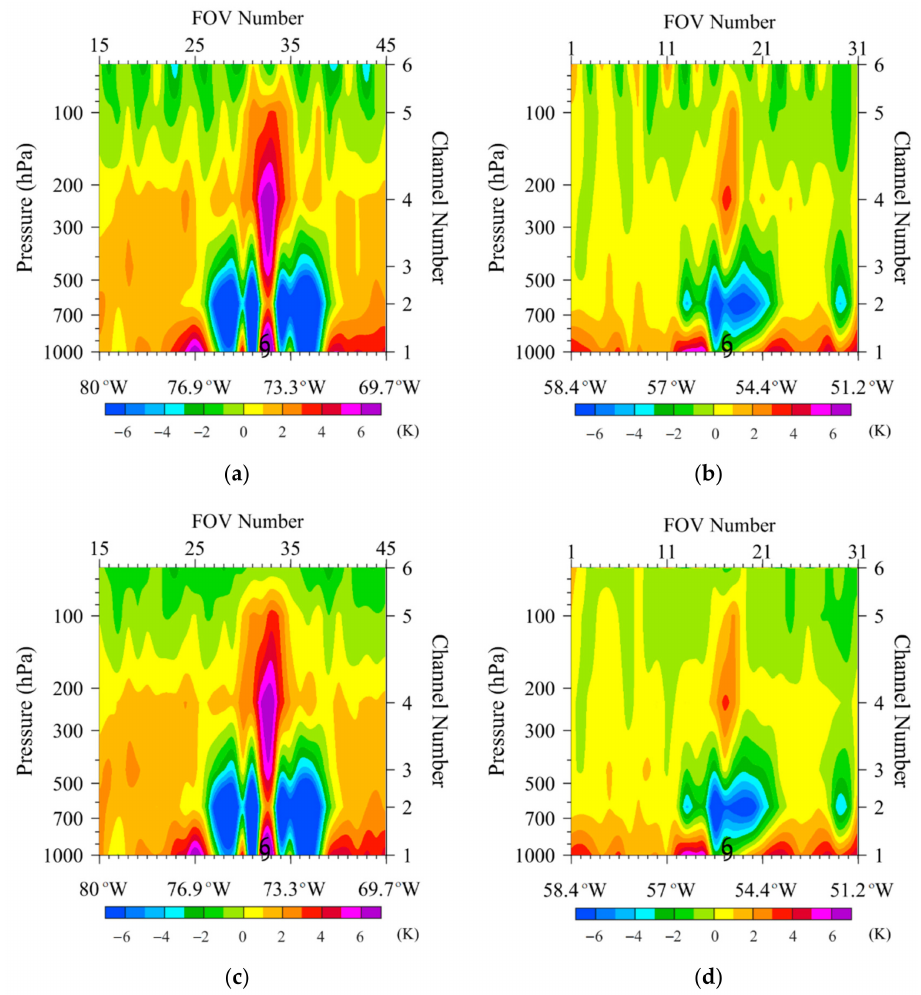
Figure 13. Cross-track cross-sections of TB anomalies at channels 1–6 along the scanline passing through the center (21.6 ◦ N, 73.9 ◦ W) of Hurricane Irma at 0906 UTC (left panels) and the center (15.9 ◦ N, 55.3 ◦ W) of Hurricane Jose at 0727 UTC (right panels) on 8 September 2017 ( a , b ) before and ( c , d ) after noise mitigation. The hurricane center position is indicated by a hurricane symbol at the bottom of each figure